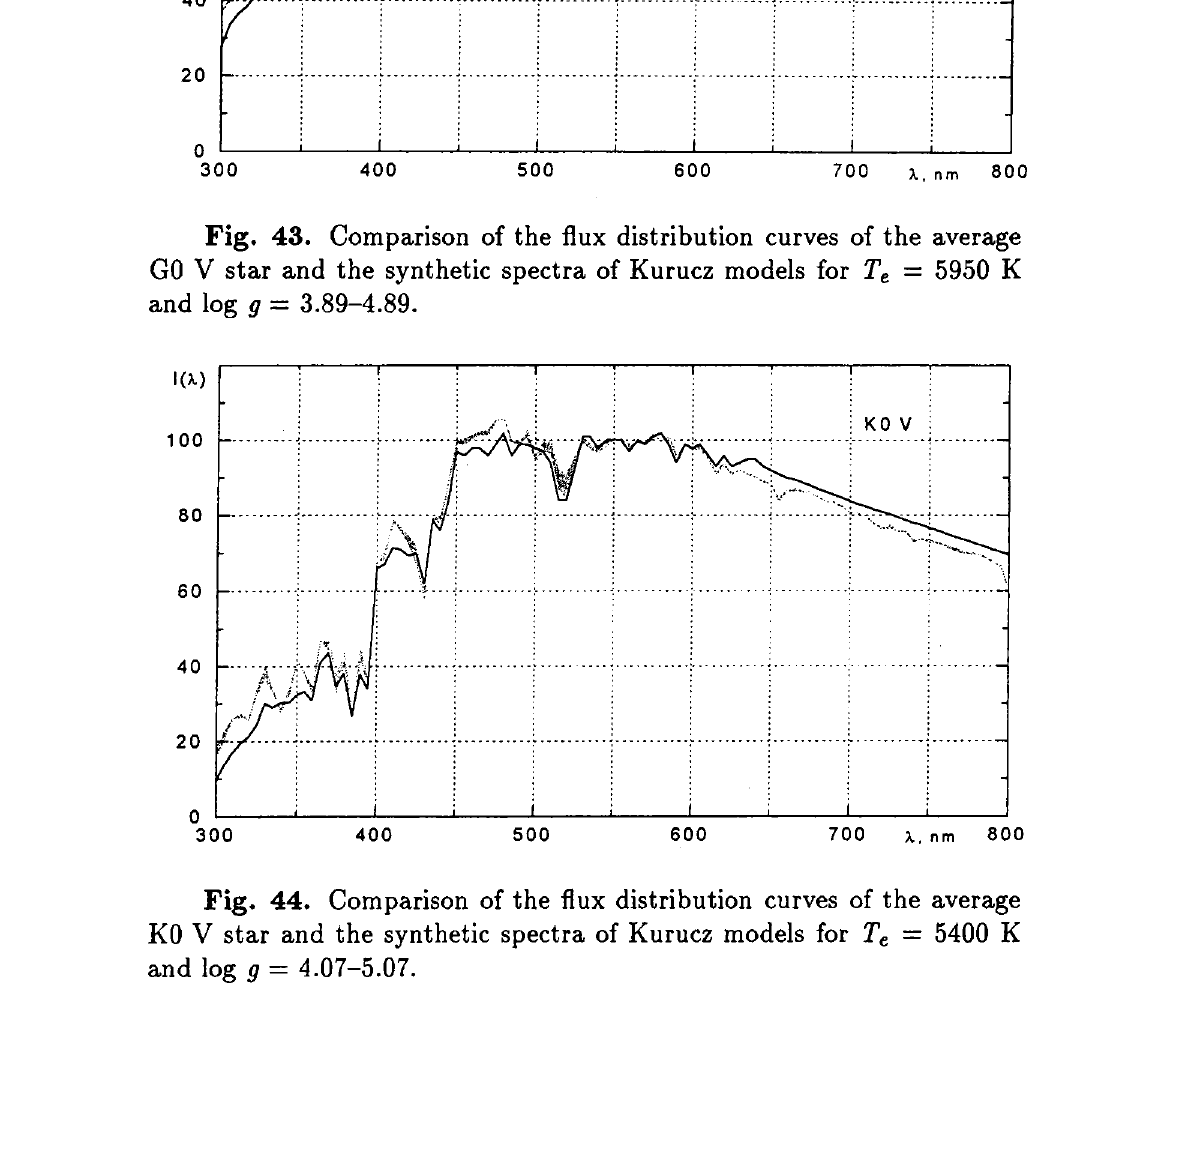
Fig. 44. Comparison of the flux distribution curves of the average K0 V star and the synthetic spectra of Kurucz models for T and log g =